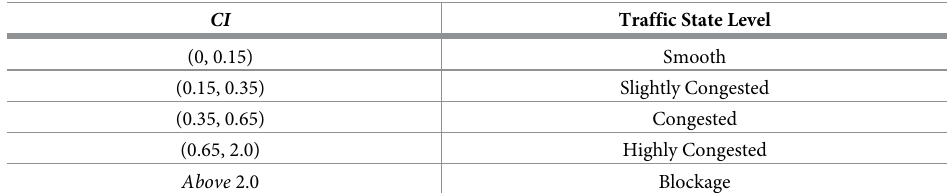
Table 2. Congestion state level.